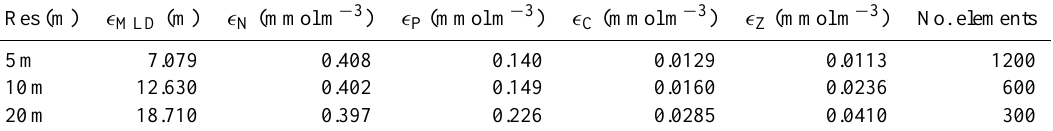
Table 3. The rms error, (cid:15) , of fixed-mesh simulations compared to the simulation with 2.5m vertical resolution at Bermuda. (cid:15) is shown for MLD, and the L2 norm of nutrient, primary productivity, chlorophyll and zooplankton. See Fig. 7 also.